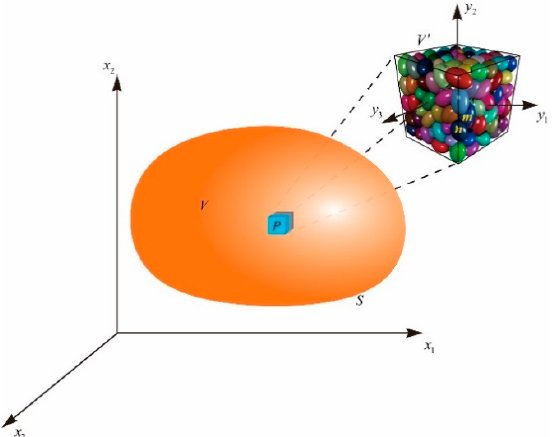
Figure 1. Macroscale material point and its granular microstructure.